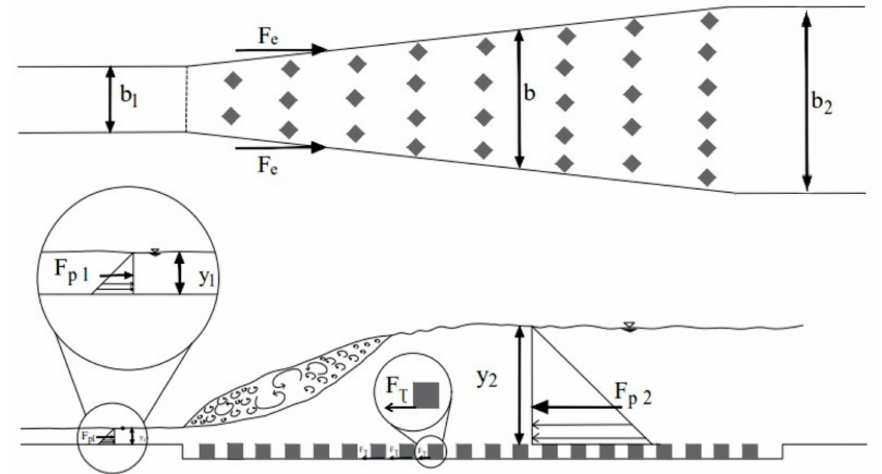
Figure 1. Basic sketch of momentum equation for the hydraulic jump on rough bed of channel with expanding walls.